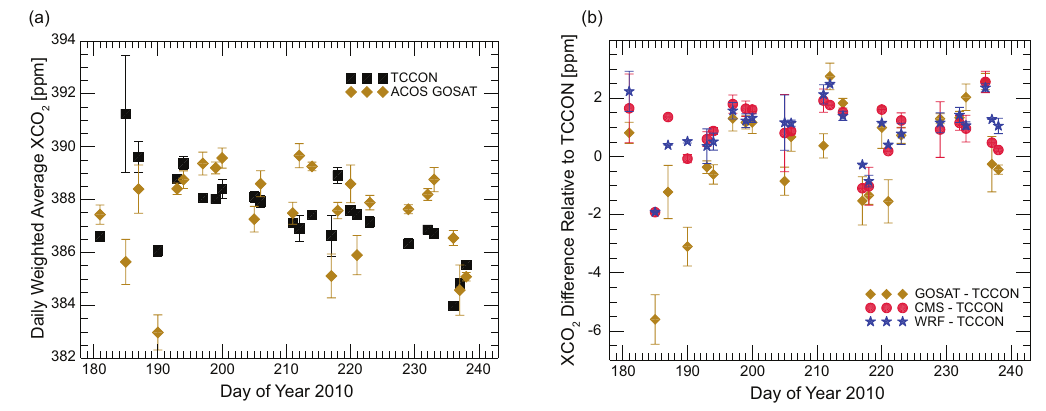
Figure 9. ( a ) A comparison of XCO 2 from GOSAT and the Lamont TCCON site in summer 2010. TCCON observations are weighted means and standard deviations during the hour of the GOSAT overpass. GOSAT observations are weighted means of soundings near the Lamont TCCON